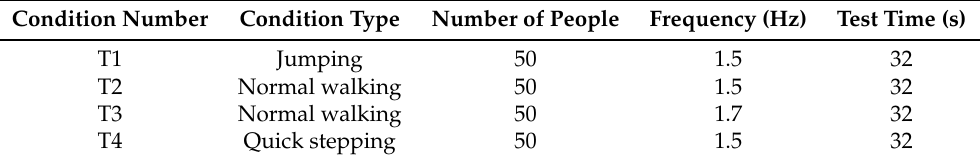
Table 1. Field test